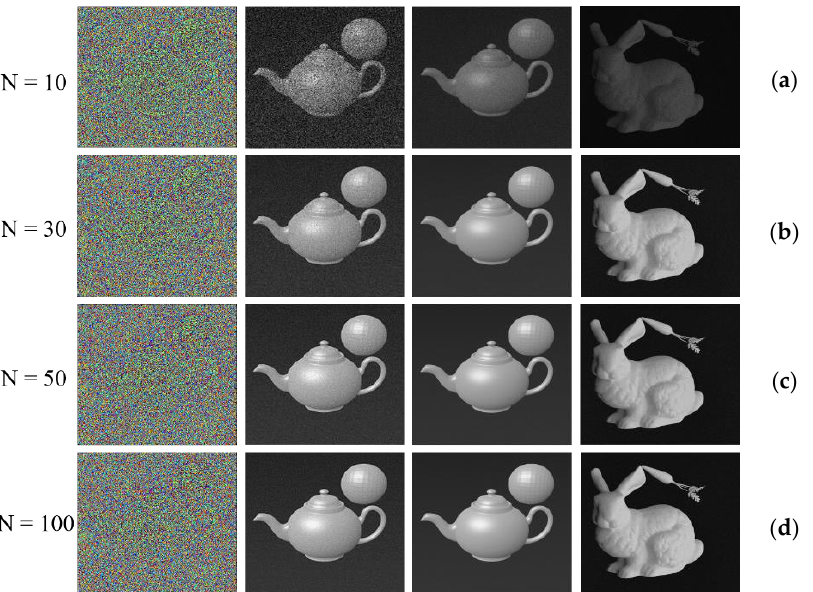
Figure 7. Numerical reconstruction of hologram synthesis at an increasing number of iterations in iterative Fourier transform algorithm: ( a ) phase distributions, ( b ) conventional hogel re-arrangement after pixel interpolation, ( c ) views by proposed pixel-mapping algorithm for the object “Teapot and sphere,” ( d ) views by a proposed pixel re-arrangement algorithm for the object “Bunny and carrot . ”